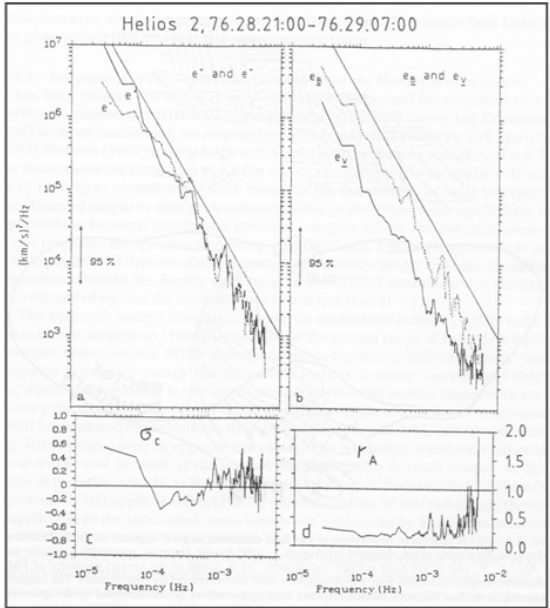
Figure 47: Left column: e + and e – spectra (top) and 𝜎 c (bottom) during a slow wind interval at 0.9 AU. Right column: kinetic 𝑒 𝑣 and magnetic 𝑒 𝐵 energy spectra (top) computed from the trace of the relative spectral tensor, and spectrum of the Alfv´en ratio 𝑟 A (bottom) Image reproduced by permission from Tu and Marsch